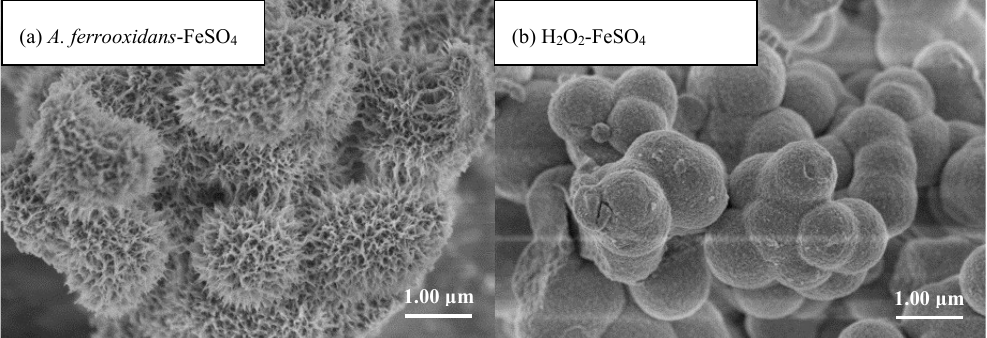
Figure 3. SEM images of ( a ) biologically and ( b ) chemically synthesized schwertmannite at 28 °C and 180 rpm for 72 h. Experimental conditions: initial pH = 3.0; FeSO 4 ·7H 2 O dosage 11.12 g; A. ferrooxidans density 6.0 × 10 6 cell·mL −1 ; H 2 O 2 volume 6 mL.